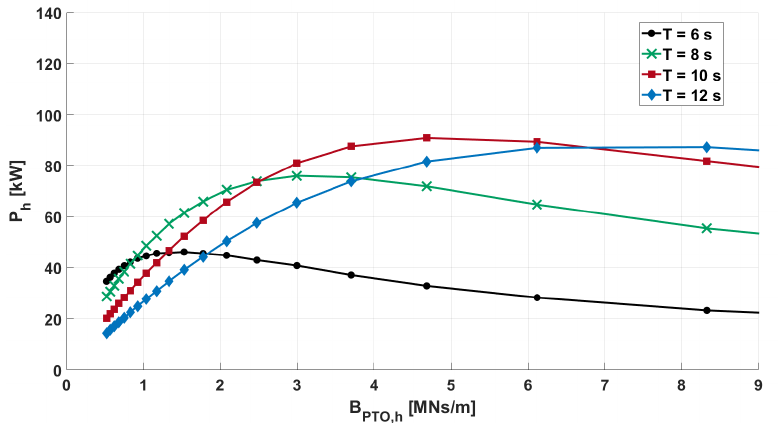
Figure 4. Average absorbed power P h as function of hydraulic damping coefficient B PTO , h for the heaving cylindrical WEC for four different wave periods and for a wave height H = 1.0